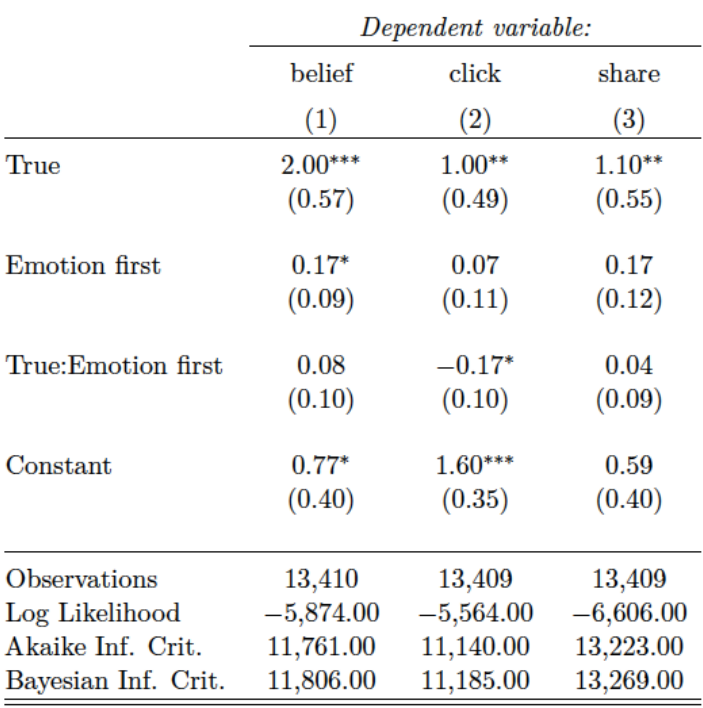
Table C10. Order of questions for each